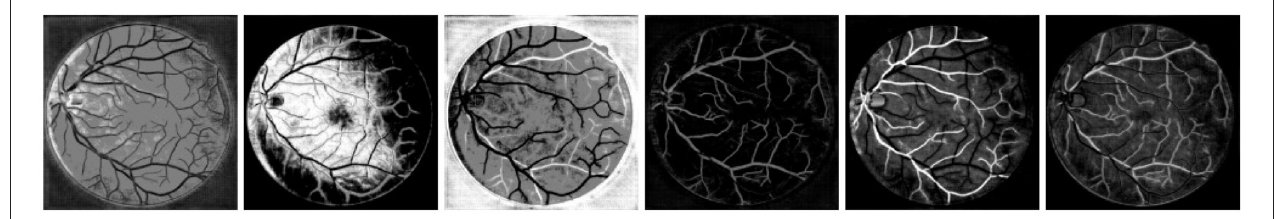
FIGURE 8 | Examples of CNN feature maps. CNN feature maps are used to generate the node features in the graph representation of VTG-Net.